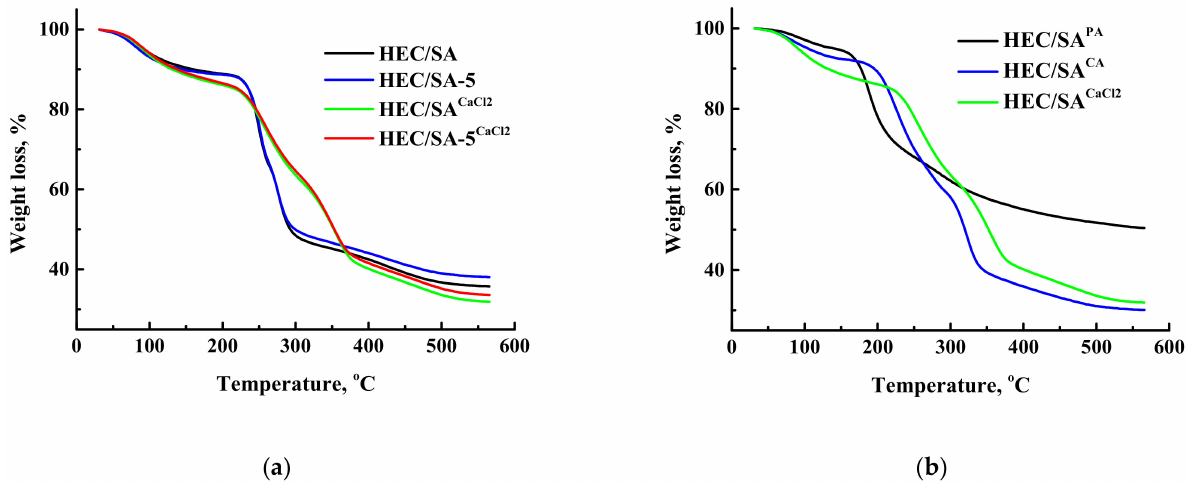
Figure 11. TG curves for ( a ) the untreated and cross-linked HEC/SA and HEC/SA/fullerenol (5%) membranes and ( b ) cross-linked HEC/SA CA , HEC/SA PA , and HEC/SA CaCl2